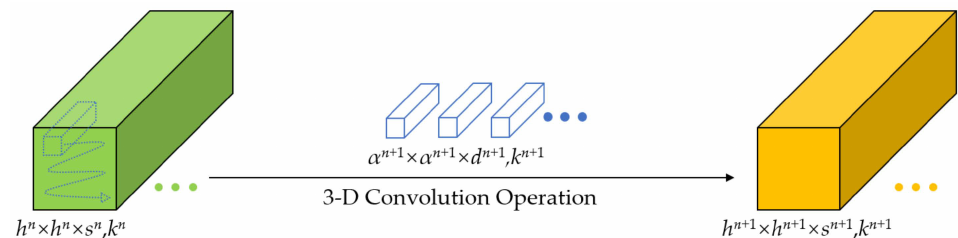
Figure 1. Illustration of the 3-D convolution operation.